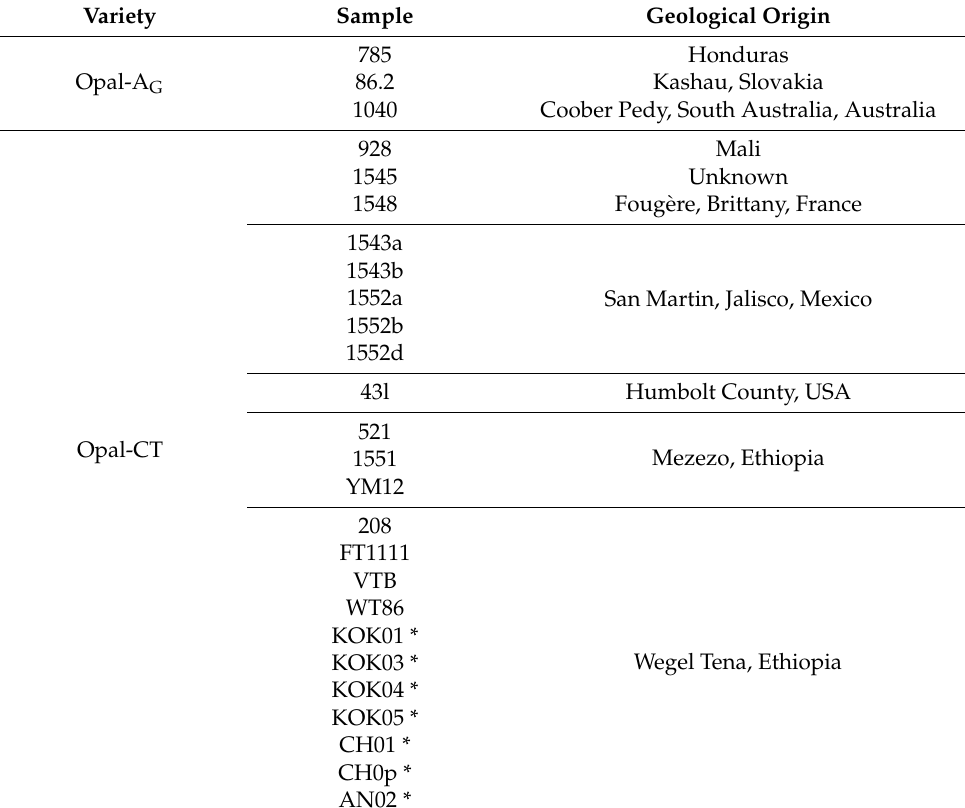
Table 1. Samples analysed in this study. The * outlines water-stored samples collected from the mining site and preserved in